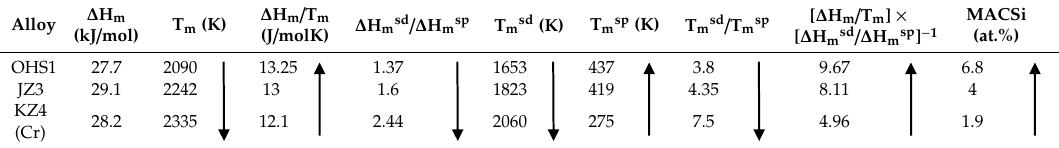
Table 6. Alloy parameters for the macrosegregation of Si in the cast alloys KZ4, JZ3 and OHS1. Table 4. Alloy parameters for the macrosegregation of Si in the cast alloys KZ5, KZ6, JZ3, OHS1. Table 4. Alloy parameters for the macrosegregation of Si in the cast alloys KZ5, KZ6, JZ3, OHS1. Table 4. Alloy parameters for the macrosegregation of Si in the cast alloys KZ5, KZ6, JZ3, OHS1. Table 4. Alloy parameters for the macrosegregation of Si in the cast alloys KZ5, KZ6, JZ3, OHS1. Table 4. Alloy parameters for the macrosegregation of Si in the cast alloys KZ5, KZ6, JZ3, OHS1. Table 4. Alloy parameters for the macrosegregation of Si in the cast alloys KZ5, KZ6, JZ3, Table 4. Alloy parameters for the macrosegregation of Si in the cast alloys KZ5, KZ6, JZ3, OHS1. Δ H m Alloy Alloy (kJ/mol)